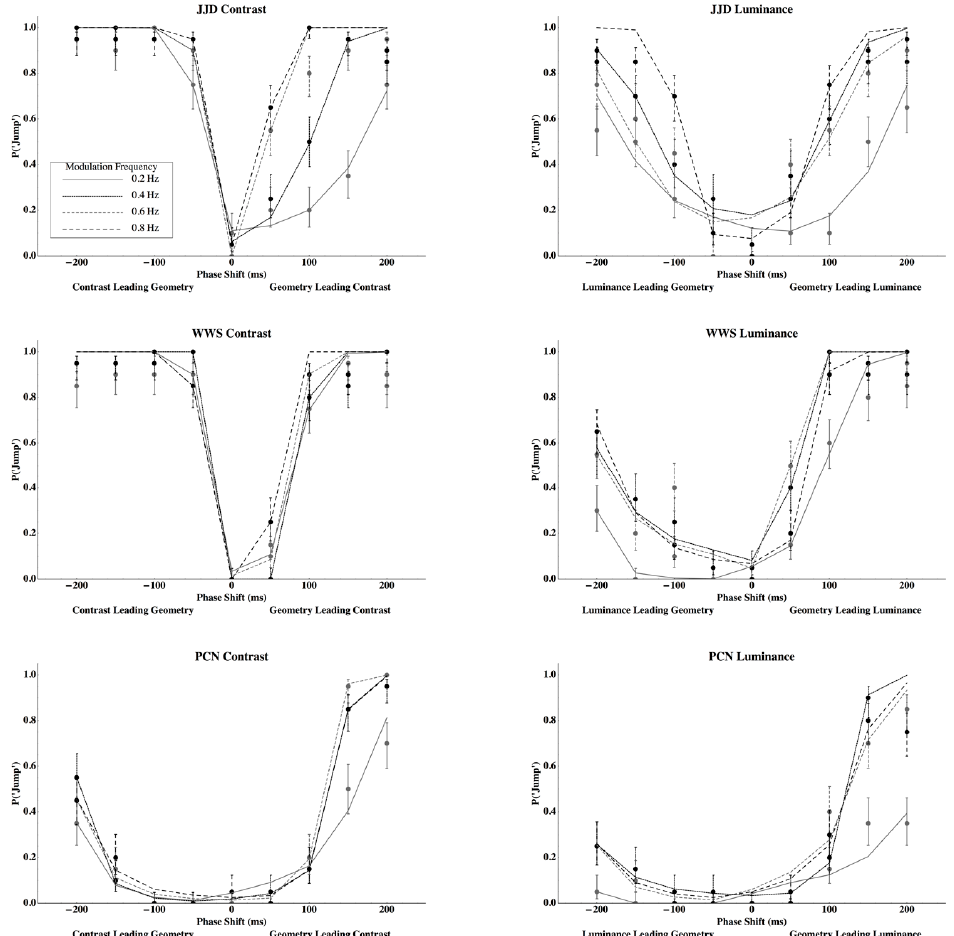
Figure 3. Data points with standard error bars describe the probability of reporting a “jump” for contrast (left) and luminance (right) disparity modulations for observer JJD (top), WWS (middle), and PCN (bottom). Standard errors are calculated using the score confidence interval (Agresti and Coull [32] (Equation (2)), Wilson, [33] with n = 20 and α = 0.318. Lines are the predicted probability of reporting a “jump” using the Gated Generalized Difference Model. Temporal offsets between contrast or luminance disparities and geometric disparities are plotted on the x -axes and the probabilities of reporting a jump are plotted on the y -axes. Individual points